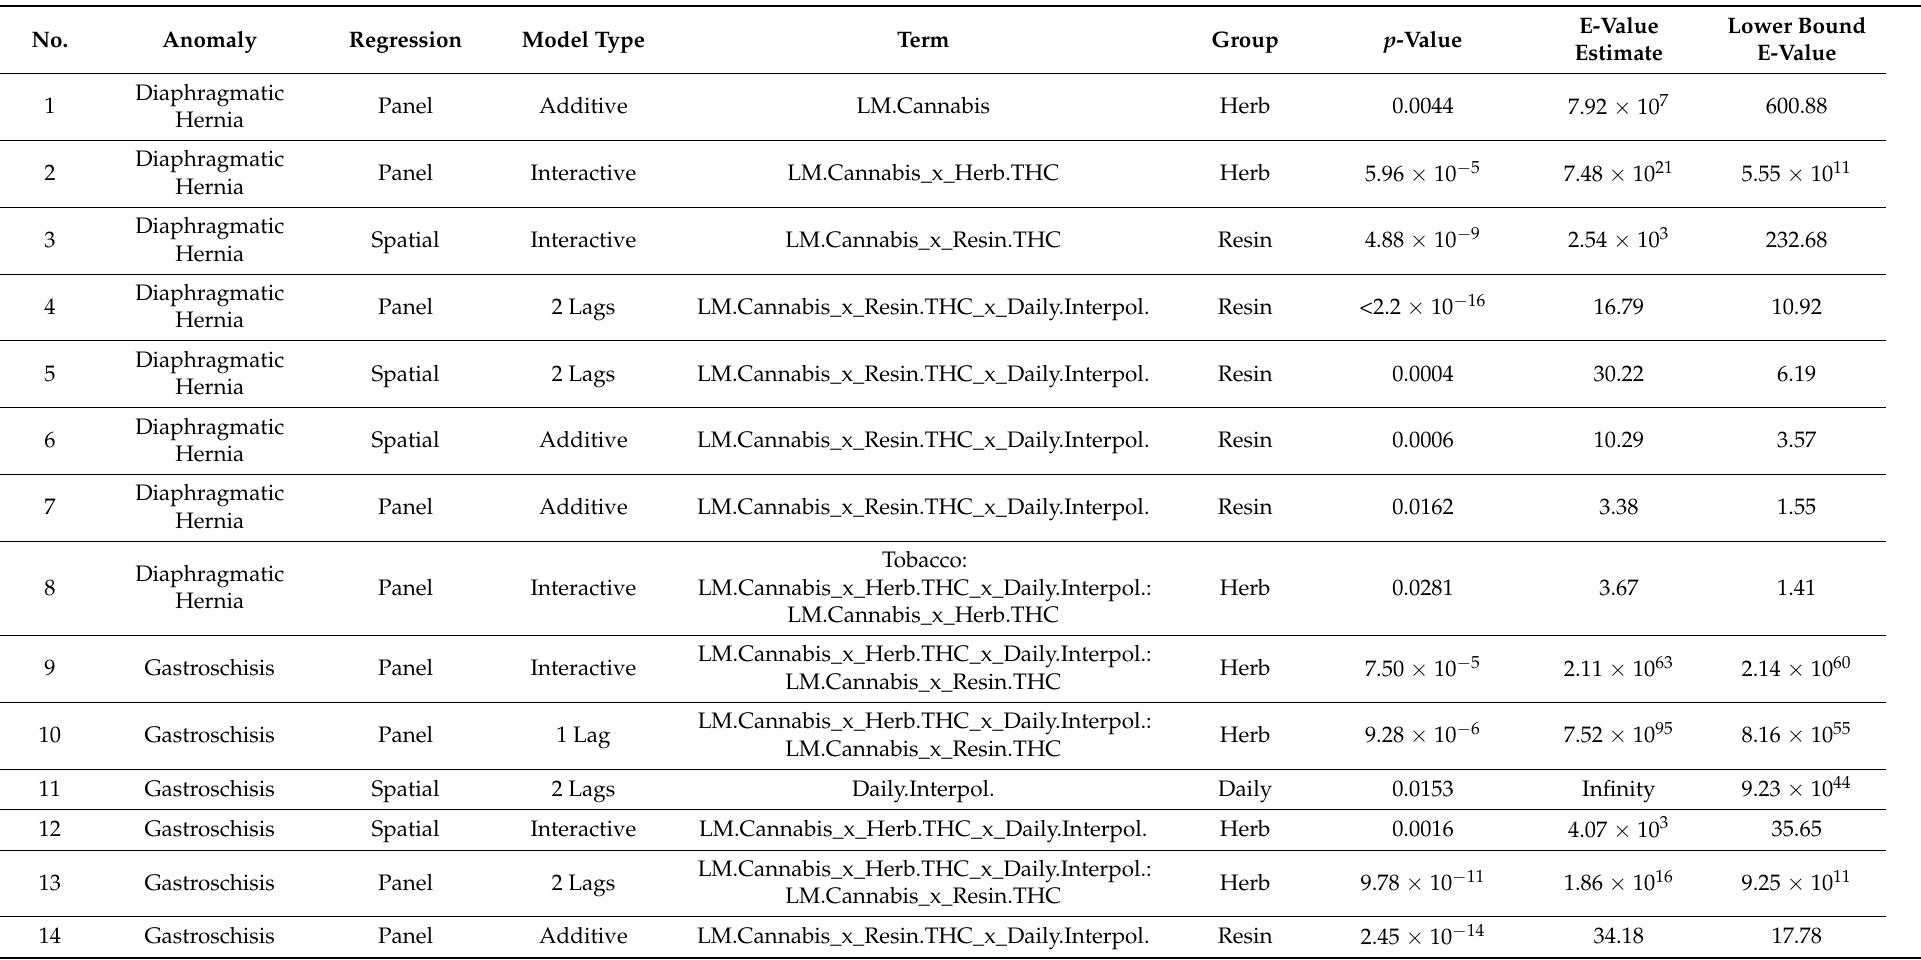
Table 9. E-Values by